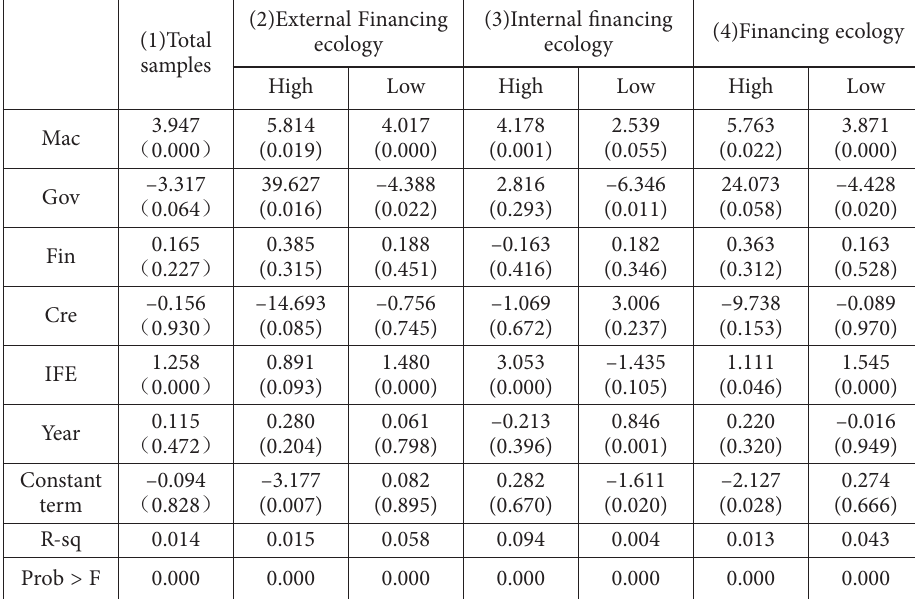
Table 8. Results of Model